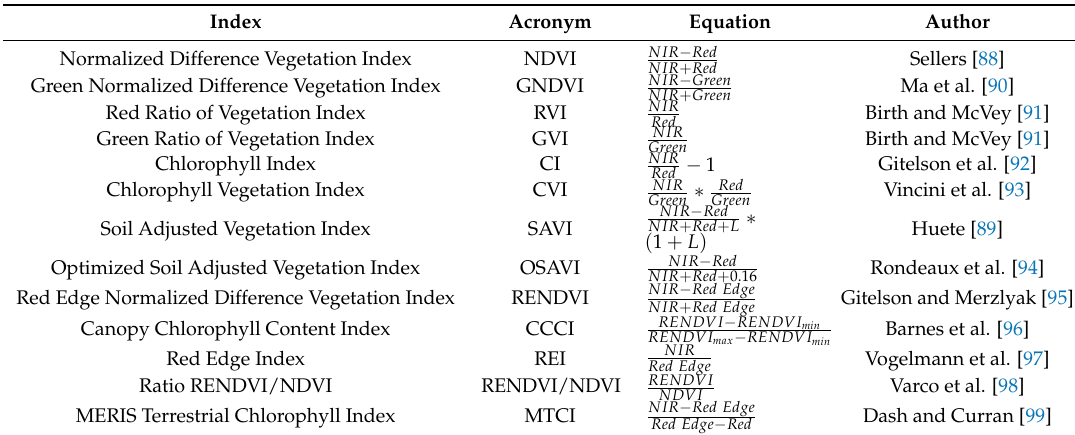
Table 2. Most commonly used canopy reflectance vegetation indices for monitoring crop N status. NIR: Near Infrared; FRed: Far red; L: soil brightness correction